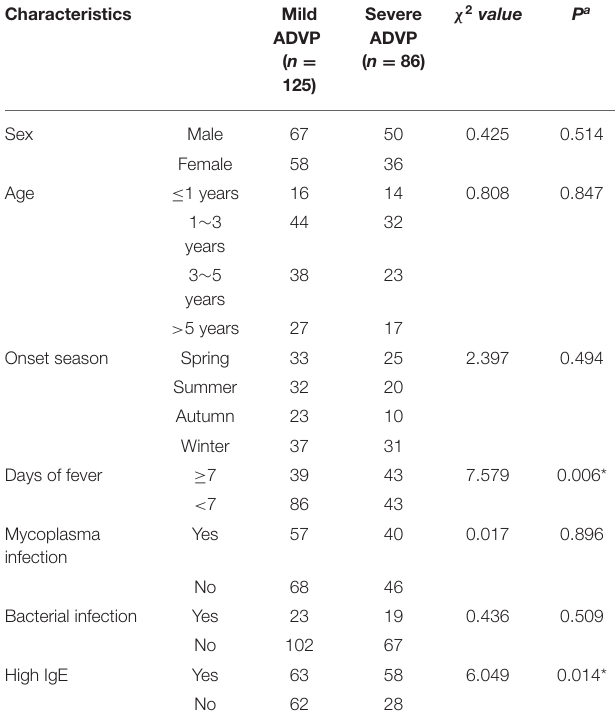
TABLE 2 | Univariate analysis between the mild ADVP group and the severe ADVP group.